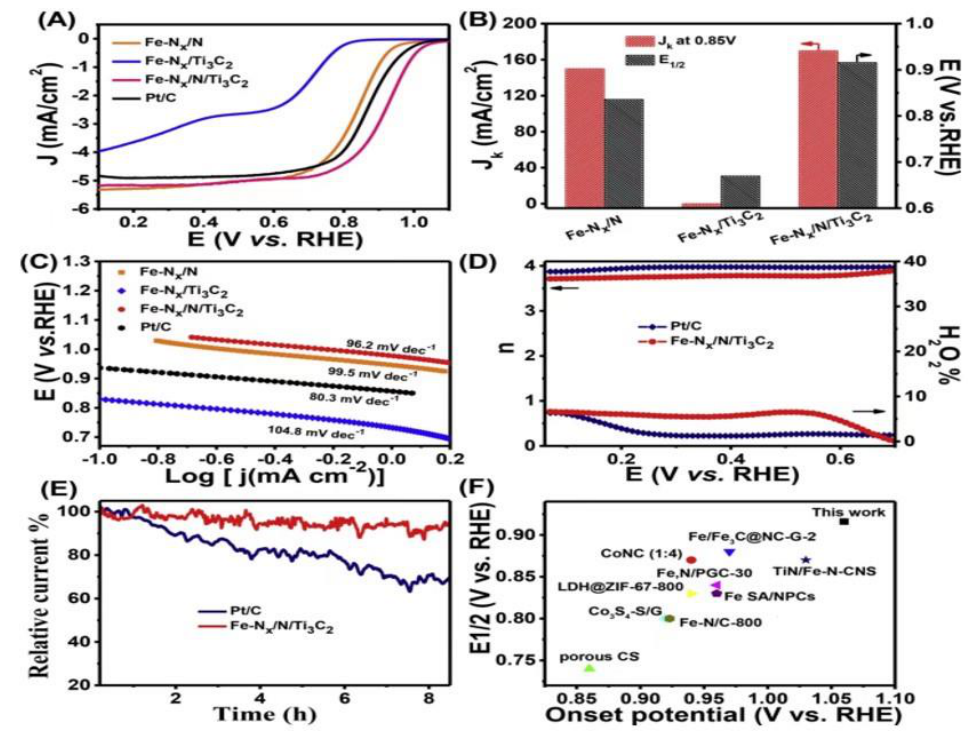
Figure 4. ( A ) ORR activity of the catalysts in an alkaline environment with 0.1 M KOH, rotation speed: 1600 rpm; ( B ) E 1/2 and J k values measured at 85 V; ( C ) Tafel plots of the catalysts; ( D ) n and peroxide yields of Fe − Nx/N/Ti 3 C 2 and the commercially available Pt/C; ( E ) Fe − Nx/N/Ti 3 C 2 and the commercially available Pt/C for i-t time-measured reactions; ( F ) comparison of Eonset and E 1/2 of Fe − Nx/N/Ti 3 C 2 with reported ORR catalysts. (Reprinted with permission from [59]. Copyright 2022, Elsevier).